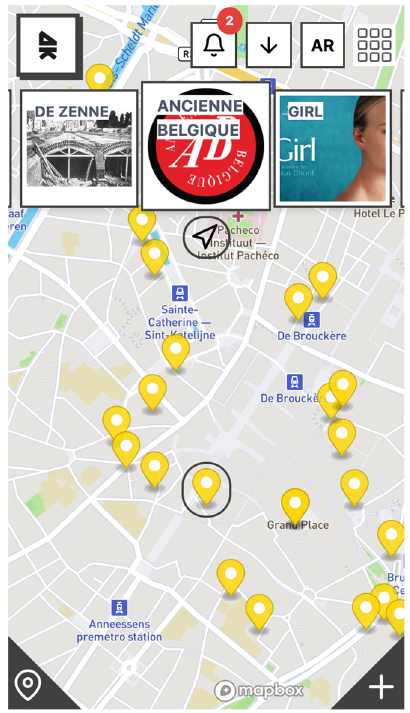
Figure 12. TICKLE’s card interface for the city game in Brussels.